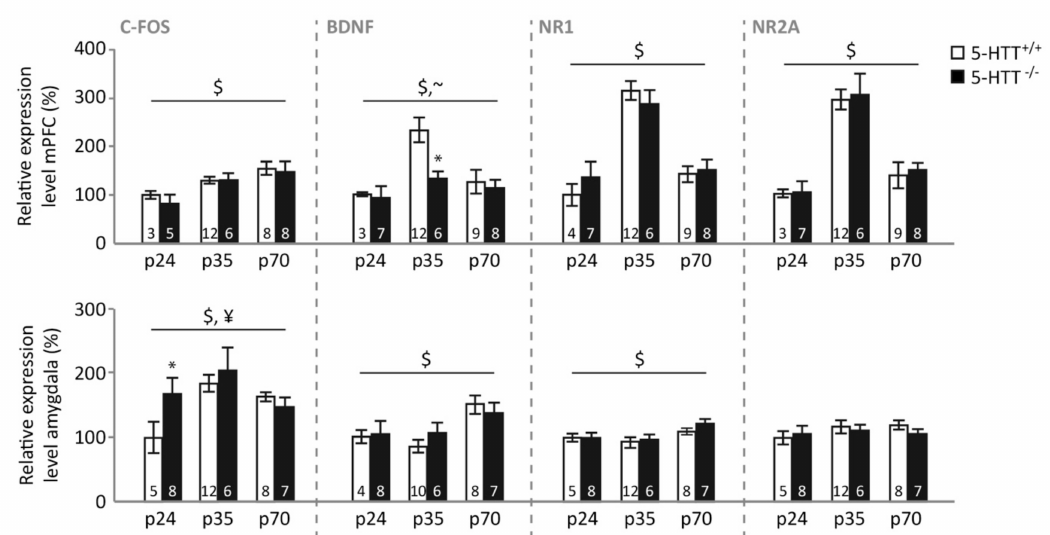
Figure 4. Relative expression levels of c-Fos, BDNF, NR1, and NR2A in the medial prefrontal cortex (mPFC) and amygdala of 5-HTT − / − and 5-HTT +/+ rats following fear extinction learning during preadolescence (p24), adolescence (p35), and adulthood (p70). #: a significant e ff ect of genotype ( p < 0.05); ~: a trend-level significant e ff ect of genotype ( p = 0.086); $: a significant e ff ect of age ( p < 0.05); ¥: a significant age × genotype interaction ( p < 0.05); *: a significant post hoc di ff erence between 5-HTT − / − vs. age-matched 5-HTT +/+ rats ( p <